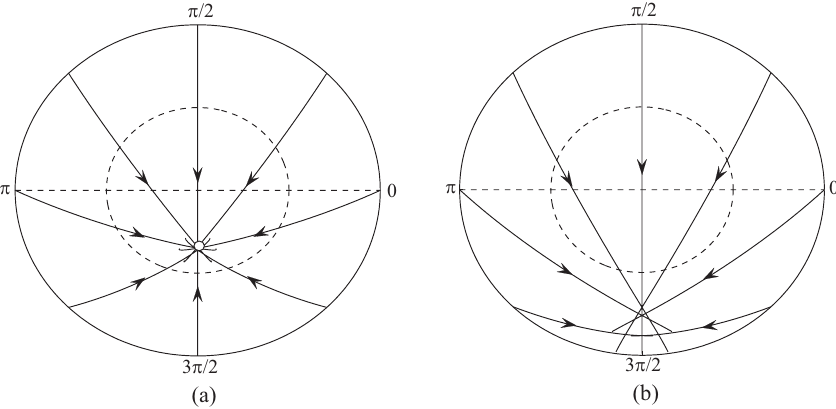
Figure 12. Trajectories of particles in cross section of channel for Sf = 0.5 ( a ) and Sf = 1 ( b ). At Sf = 0.5, a specific zone of counter-oscillatory motion of particles is formed in the vicinity of the singular point. As the Sf parameter increases to 1, this zone expands, deforms, and captures the lower part of the channel. The change in the structure of this flow zone is accompanied by the precipitation of some particles from the flow onto the channel